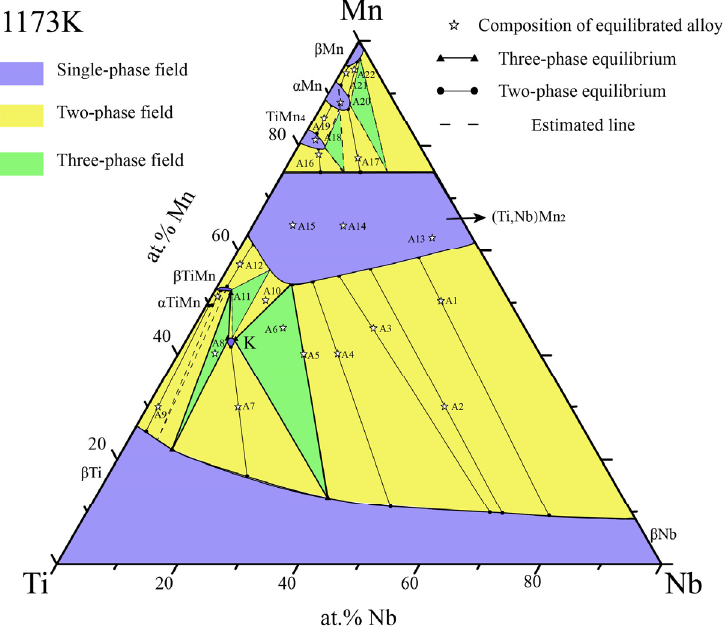
Figure 4. Isothermal section of Ti-Nb-Mn ternary system at 1173K determined in this work.